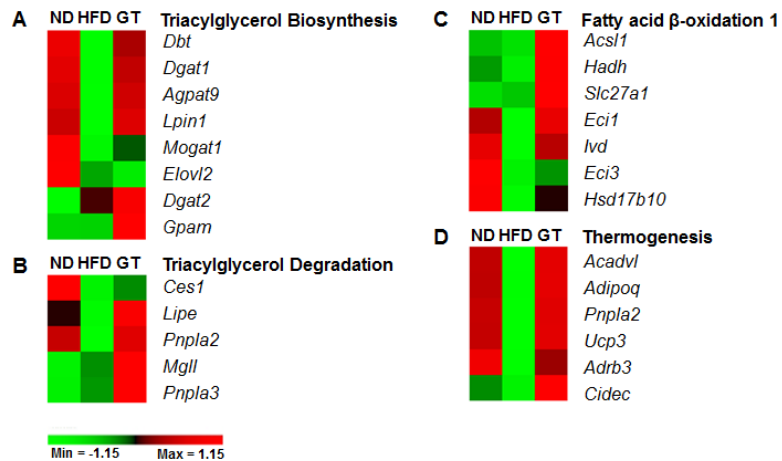
Figure 5. Expression profiles of lipid metabolism ‐ related genes in epididymal white adipose tissue (eWAT) of diet ‐ induced obese C57BL/6J mice treated with green tea extract for 12 weeks. ND, normal diet, AIN ‐ 93G; HFD, high ‐ fat diet, 60% kcal from fat; GT, green tea extract, 0.25% w / w . The significant pathways and functions were obtained via Ingenuity Pathway Analysis (IPA).